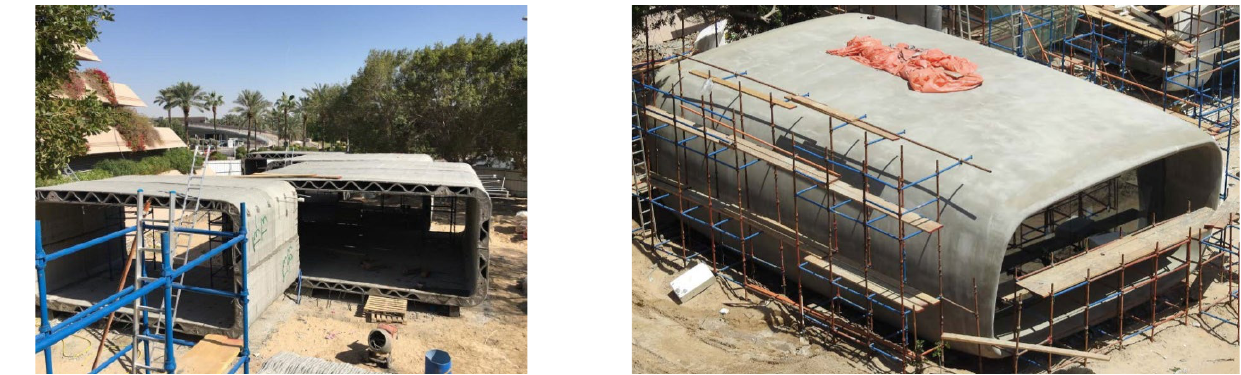
Figure 8. Architectural design of a 3D-printed office in Dubai [55].